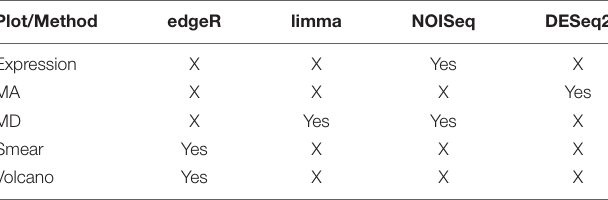
TABLE 2 | Plots generated by each differential expression package. Plot/Method edgeR